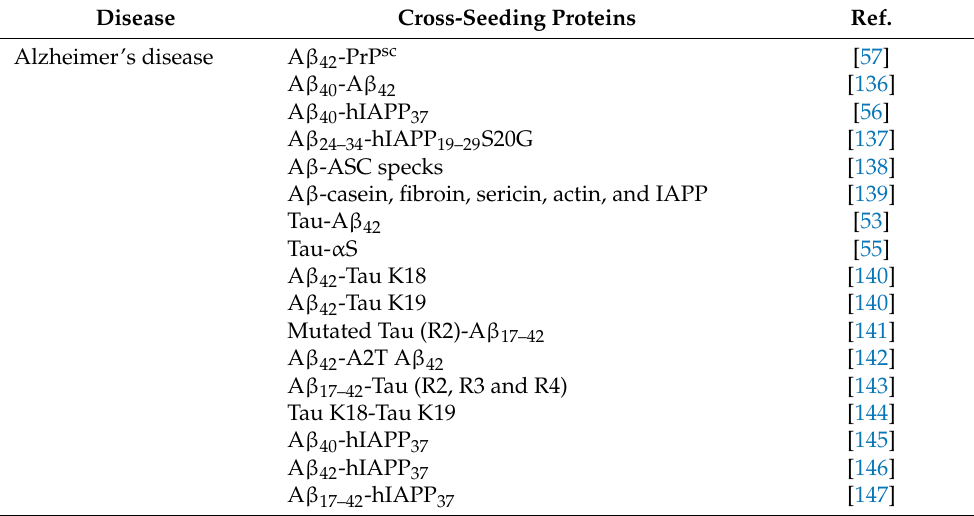
Table 1. List of diseases and the cross-seeding amyloid proteins found by different experimental and computational